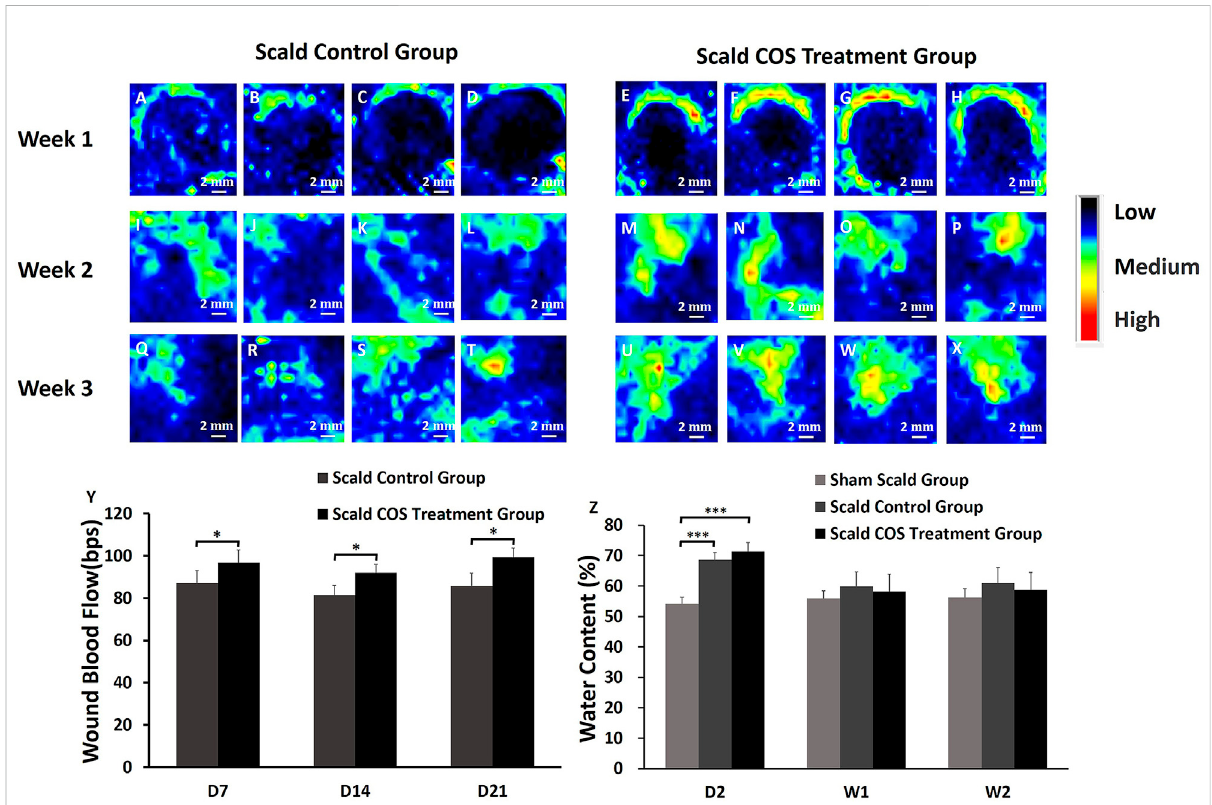
FIGURE 3 Blood perfusion on the wound surface of rats in the scald groups. Black indicates the area with low or no blood perfusion, and the blood perfusiongraduallyincreasesforblue,yellow,green,andred (A – X) Typicalimagesofbloodperfusioninthewoundsofrats. (Y) Comparisonofblood perfusion on the wounds of the two groups of rats. (Z) Comparison of the water content of skin tissue among the three groups. * p < 0.05, *** p < 0.001. The scale bar represents 2